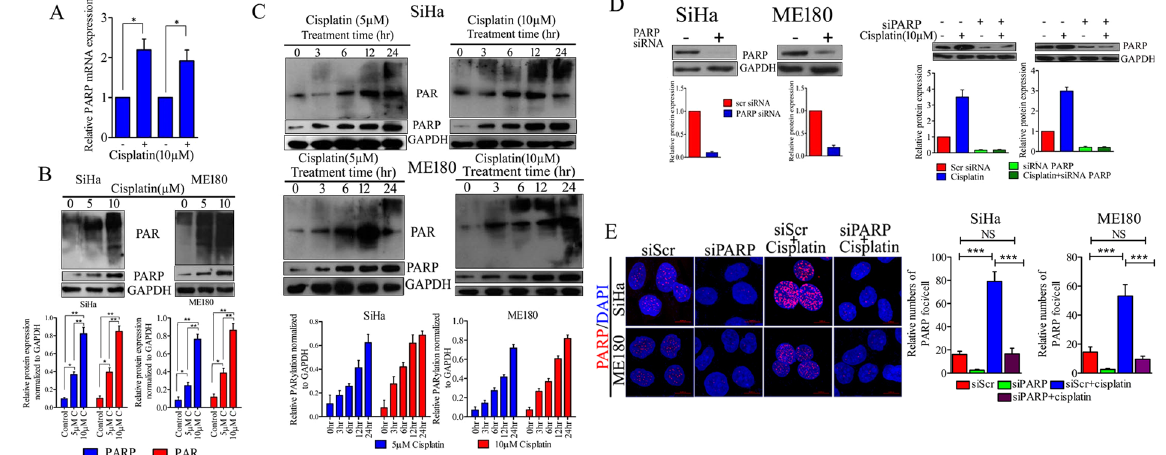
Figure 2. Cisplatin induces PARP1 over expression and hyperactivation in CC cell lines. ( A ) Graph showing relative PARP1 mRNA expression in SiHa and ME180 CC cell lines after 24 hr cisplatin (10 μ M) treatment. (SiHa control vs. cisplatin * p = 0.0205, ME180 control vs. cisplatin * p = 0.0351). ( B ) Representative western blot showing expression of PARP1 and PAR polymers in SiHa and ME180 cell lines treated with 5 µ M and 10 µ M cisplatin for 48 hrs. Bar graph displaying normalized band density of PARP1 and PAR normalized to GAPDH. Error bar display the S.D. from the mean of 3 independent experiments. * p = 0.01, ** p = 0.007. The full size blots corresponding to the cropped blot images are given in Supplementary Figure S12. ( C ) Western blot showing PARP1 and PAR expression in SiHa and ME180 cell lines treated with 5 µ M and 10 µ M for indicated time duration. Bar graph displaying normalized band density of PARP1 and PAR normalized to GAPDH band intensity of respective blot image. The full size blots corresponding to the cropped blot images are given in Supplementary Figure S12. ( D ) Transfection with specific PARP1 siRNA shows depletion in basal PARP1 protein level as well as cisplatin induced PARP1 overexpression. Bar graph displaying relative protein expression normalized to GAPDH. The full size blots corresponding to the cropped blot images are given in Supplementary Figure S12. ( E ) Representative immunofluorescence image showing nuclear localization of PARP1 in SiHa and ME180 cell lines. 24 hrs cisplatin treated cell shows enhanced number of PARP1 foci in both cell lines. Bar graph displaying quantitative distribution of PARP1 foci in respective treatment